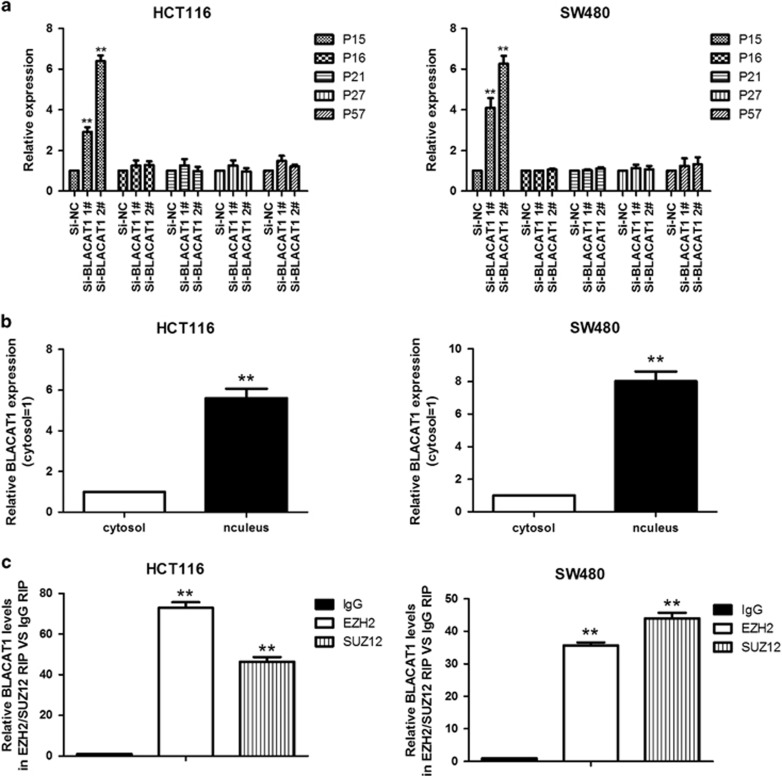
BLACAT1 is associated with PRC2 in CRC. (a) The expression of p15, p16, p21, p27 and p57 were determined after knockdown of BLACAT1 using qRT-PCR. (b) BLACAT1 nuclear localization, as identified using qRT-PCR in fractionated HCT116 and SW480 cells. After nuclear and cytosolic separation, RNA expression levels were measured by qRT-PCR. GAPDH was used as a cytosolic marker. (c) RIP experiments were performed, and the co-precipitated RNA was subjected to qRT-PCR for BLACAT1. The fold enrichment of BLACAT1 in RIPs is relative to its matching lgG control RIP. **P<0.01